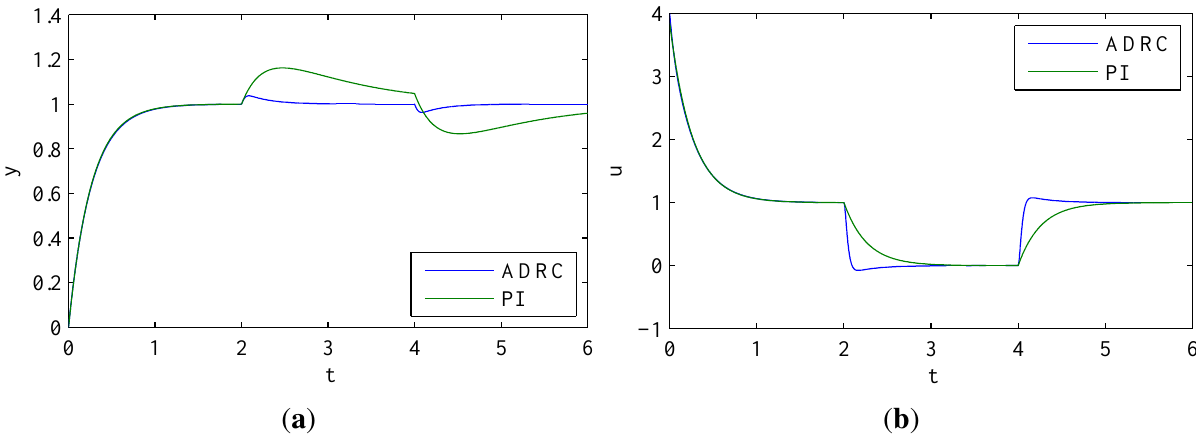
Figure 10. Experiment 3.1.7: comparison of disturbance rejection behavior (first-order ADRC vs . PI controller). Process and ADRC parameters are as throughout Section 3.1. Input disturbance, d = 1, was effective from t = 2 until t = 4. ( a ) Step response and reaction on disturbance; ( b ) Controller output u for ( a